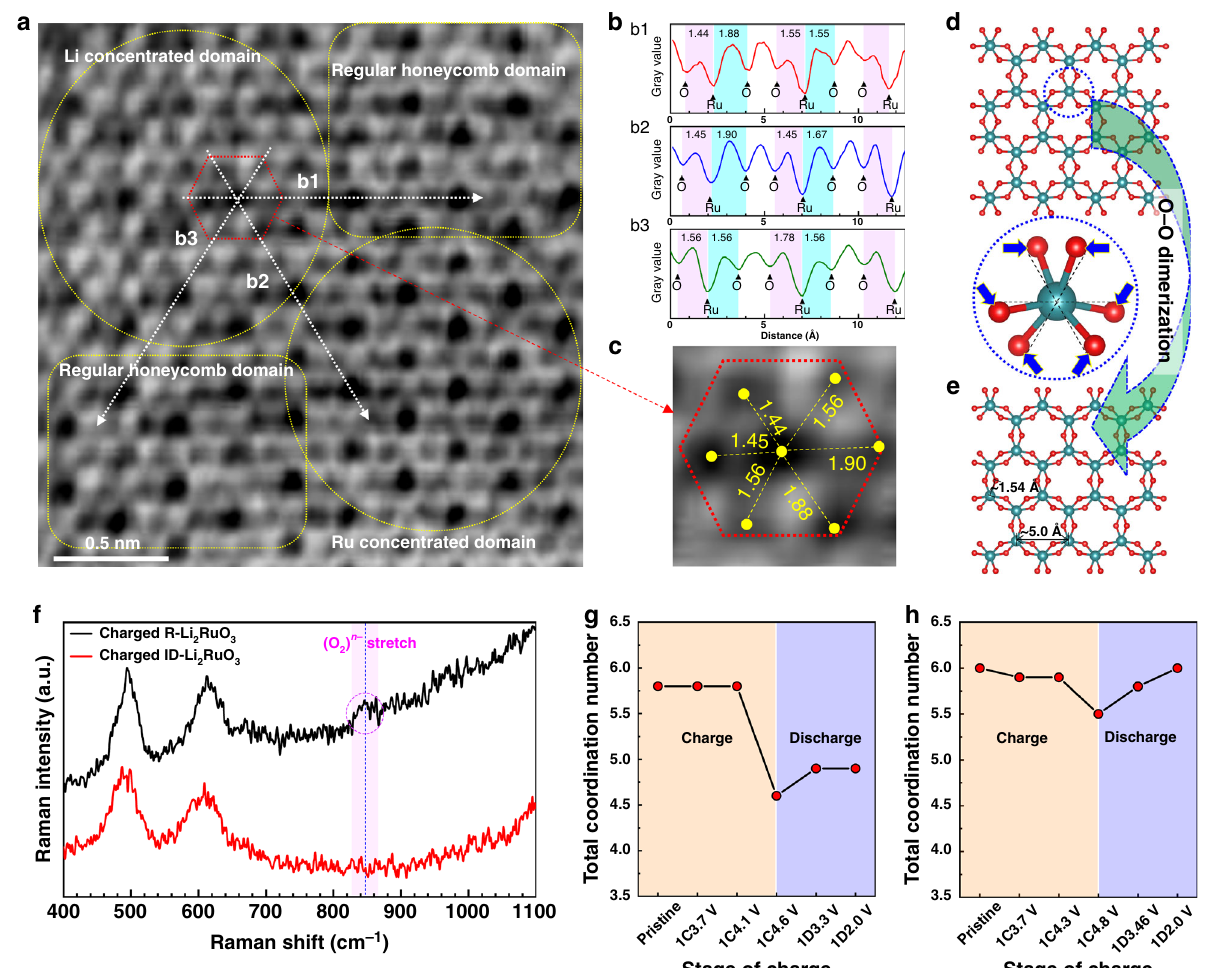
Fig. 7 The local structural changes upon charging and discharging. a The ABF-STEM image of 4.8 V charged ID-Li 2 RuO 3 along [001] zone axis. b The gray value variation of ABF-STEM image along b1, b2, and b3 directions (marked with white dotted arrows). c The enlarged ABF-STEM image of the of the red hexagon marked RuO 6 , the value between dark black dot and light black dot are the corresponding projected Ru – O distances. d , e The schematic Ru – O arrangement of Li 2 – x RuO 3 before ( d ) and after ( e ) O – O dimerization. f The Raman spectra of 4.8 V charged ID-Li 2 RuO 3 and R-Li 2 RuO 3 . g , h The variation of total coordination number of R-Li 2 RuO 3 ( g ) and ID-Li 2 RuO 3 ( h ) during charge and discharge processes, obtained from EXAFS fi tting. 1C and 1D represent the fi rst charge and discharge,